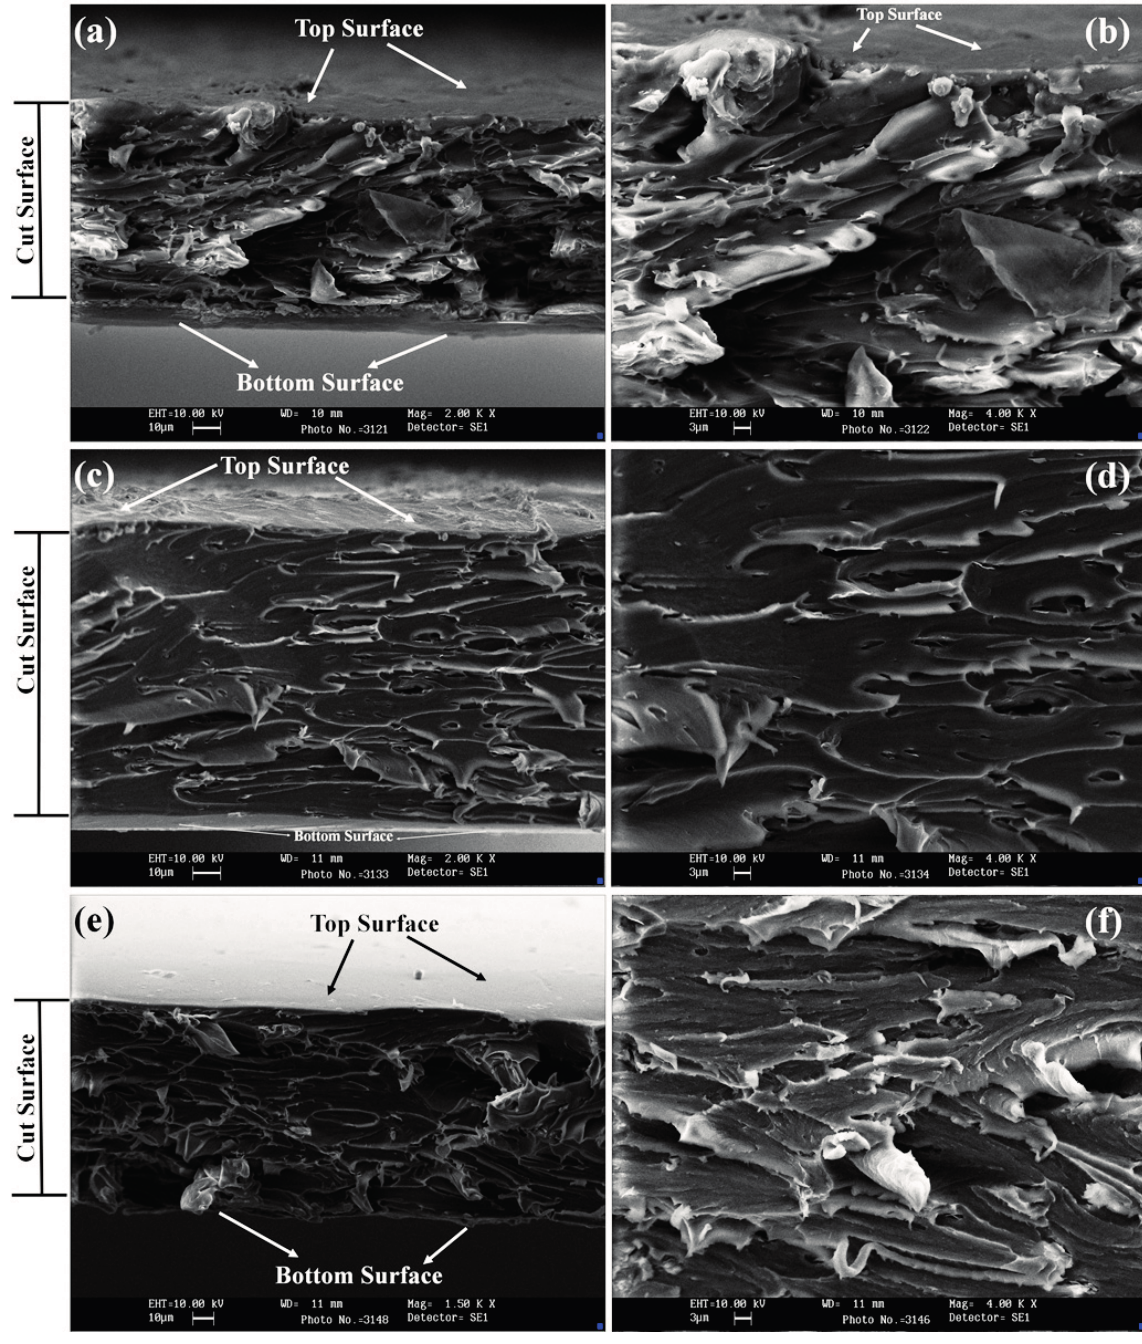
Figure 7. SEM images of the fractured zone of ( a , b ) GR/CS; ( c , d ) o-GR/CS and ( e , f ) f-GR/CS composite